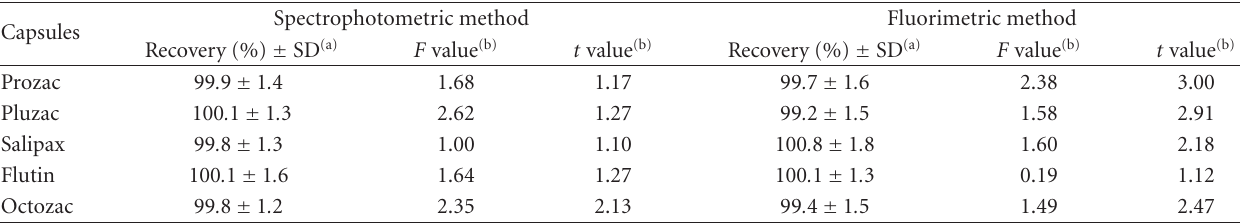
Table 6: Determination of FLX in its pharmaceutical formulations (capsules) by the proposed spectrophotometric, fluorimetric and the o ffi cial methods.